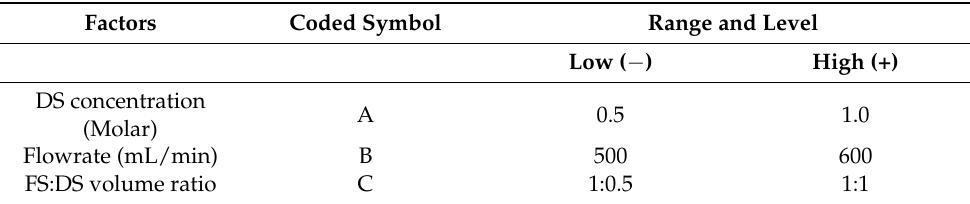
Table 4. Experimental ranges and levels of the factors used in the full factorial design (FFD). Factors Coded